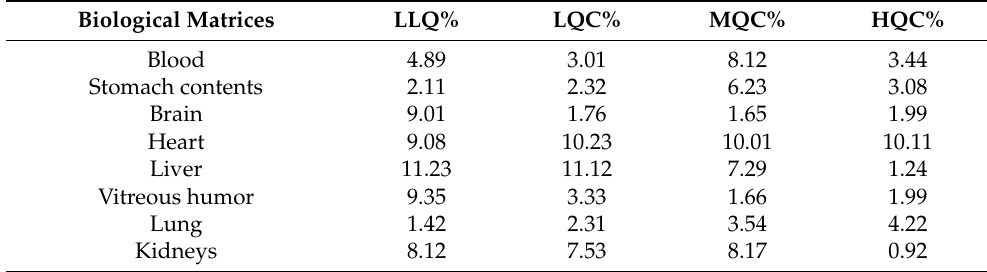
Table 12. Lower limit of quantification (LLQ), low-quality control (LQC), medium-quality control (MQC), and high-quality control (HQC) calculated in each matrix, in triplicate, intracutaneous and intercurrent to 3-OH-carbofuran.